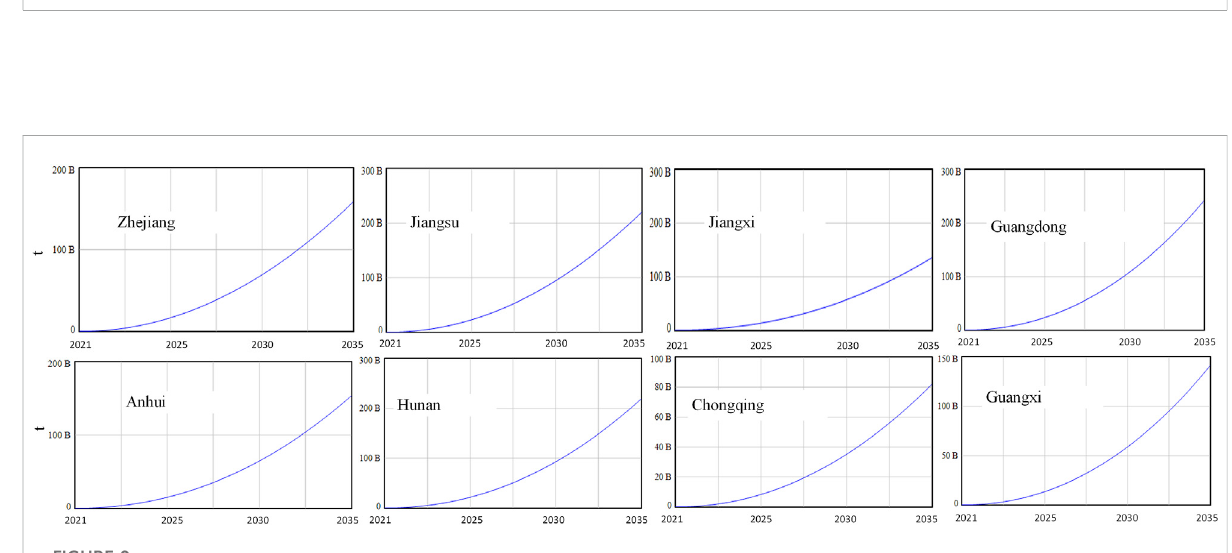
FIGURE 9 BAU scenario of CO 2 emissions of various provinces and cities in non-central heating